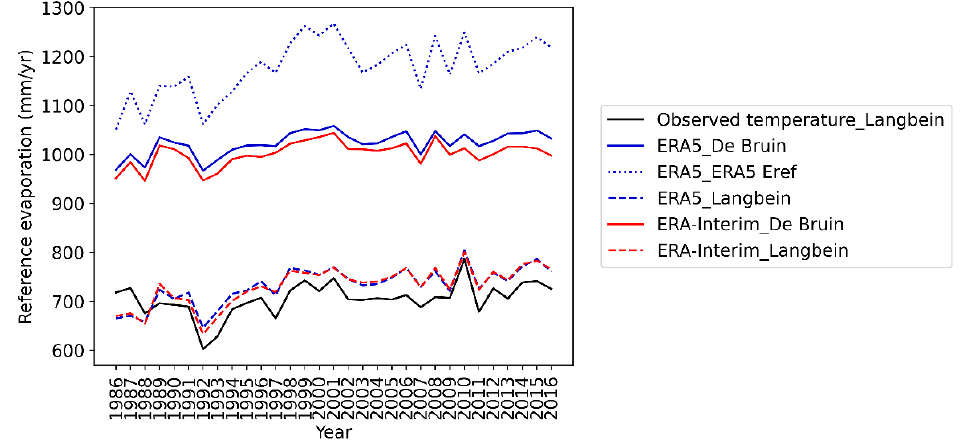
Figure 5. Comparison of retrieved reference evaporation (Eref) from ERA5 with Eref values calculated by De Bruin and Langbein methods using ERA5, ERA-Interim, and observed data in the Urmia Lake Basin.